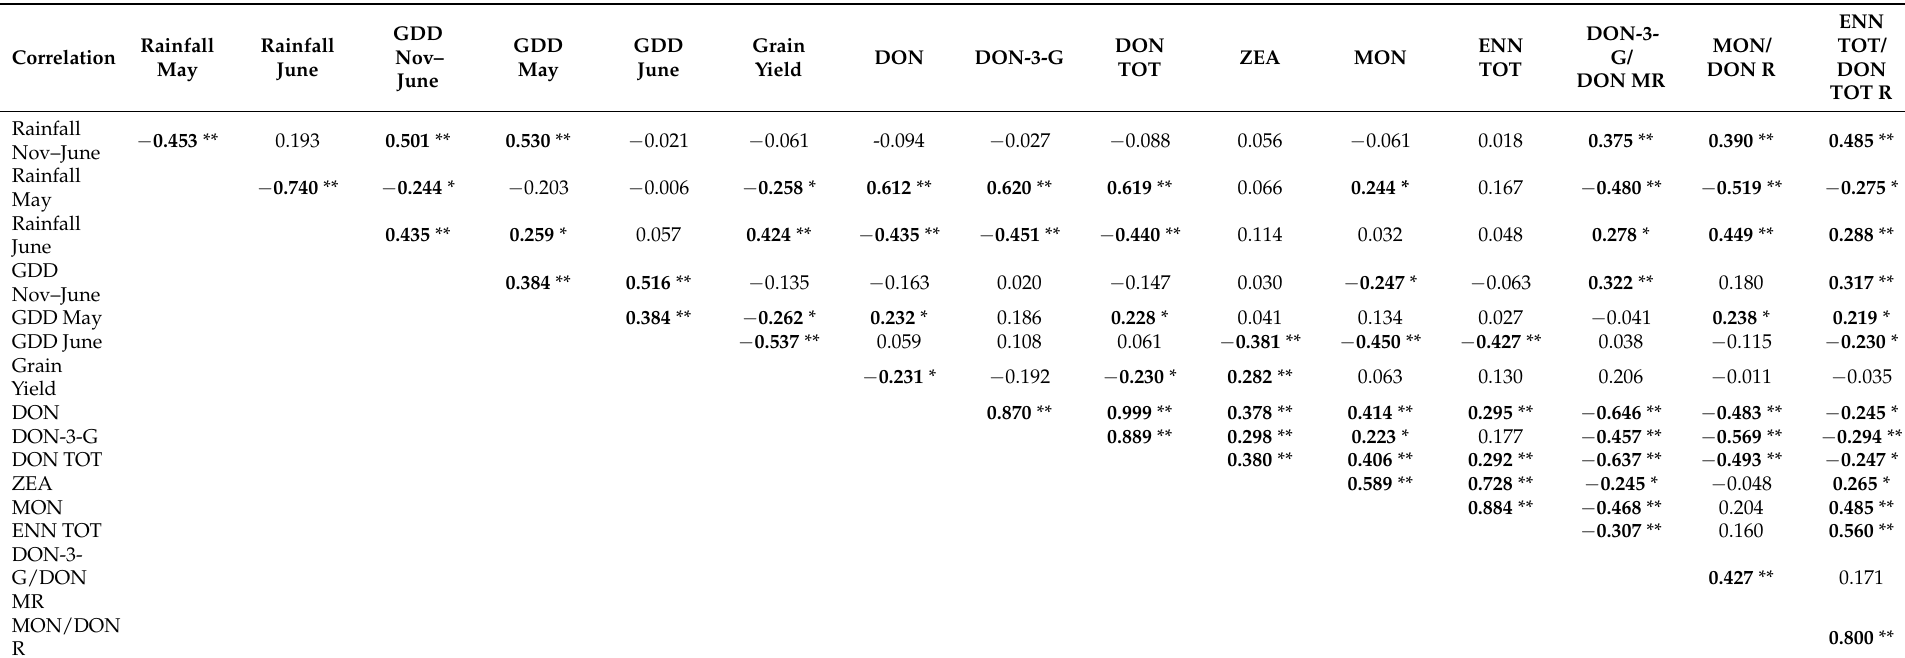
Table 5. Correlations between agro-meteorological parameters and